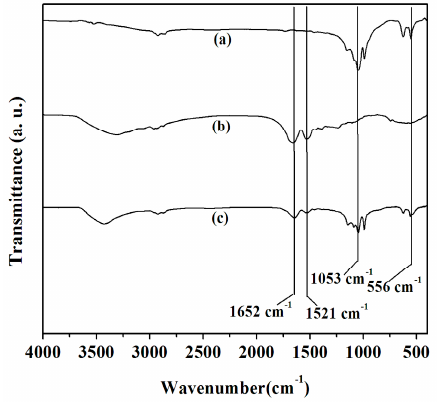
Figure 2. The FTIR spectrum of Cu 3 (PO 4 ) 2 matrices (curve a), APE1547 (curve b) and the immobilized APE1547 (curve c).